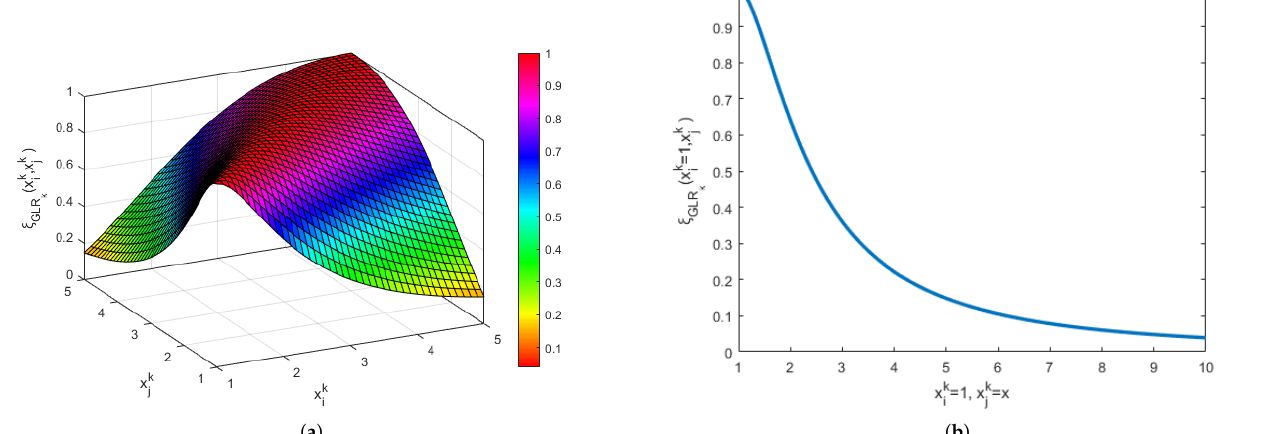
) based on GLR. ( a ) The X and Y axes indicate values of x k , x k i j = 1 and x k are taken from 1 to i j